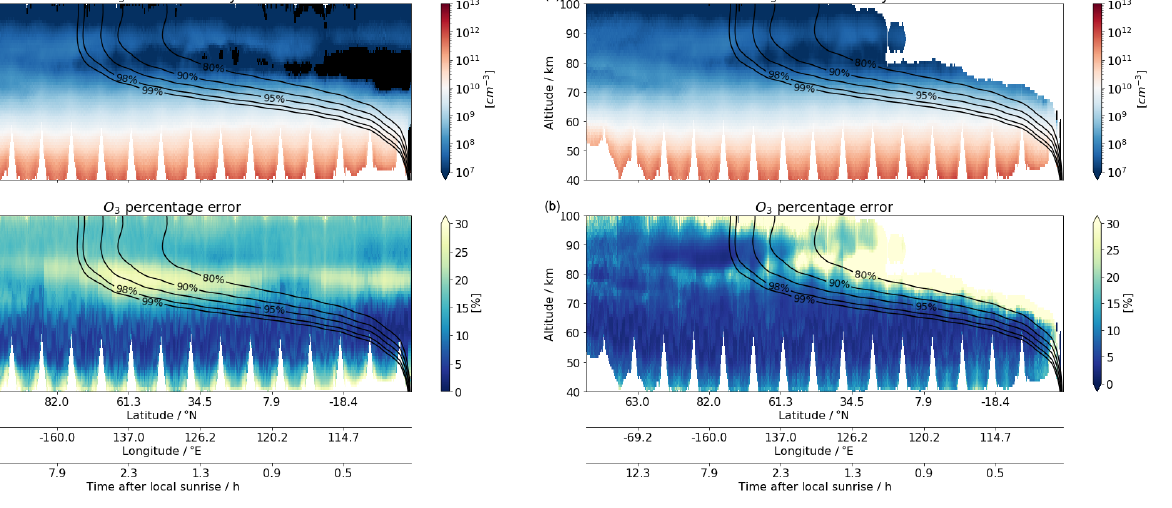
Figure 8. The same as Fig. 7 but showing the final estimation with the adjustment of the equilibrium